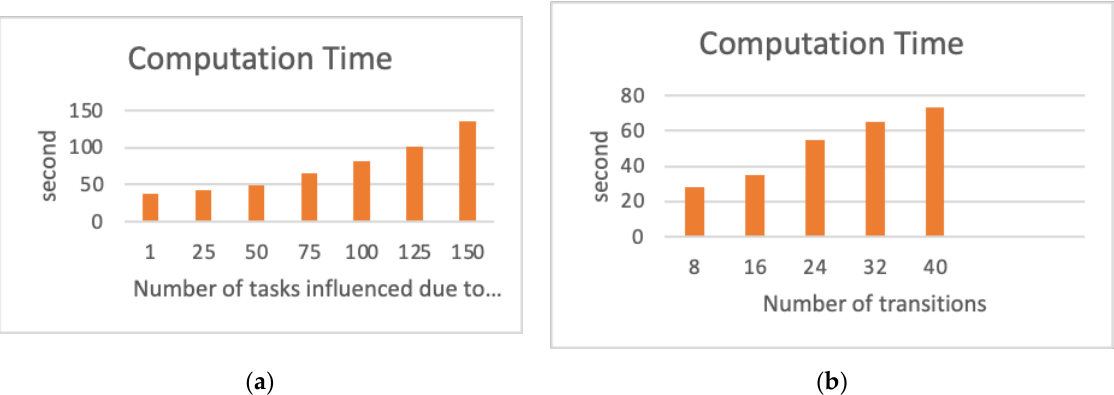
Figure 7. ( a ) Computational time with respect to the number of tasks influenced, Q δ j , due to resource failures; ( b ) Com- putational time with respect to number of transitions in task subnets.